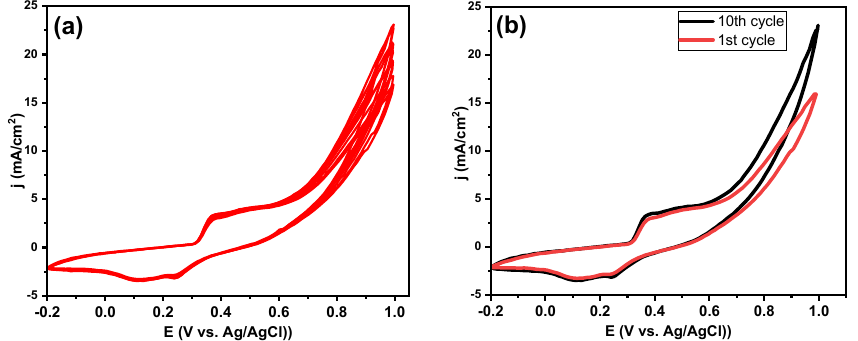
Figure 4. ( a ) CV curve acquired over ten cycles and ( b ) 1st and 10th cycle in 1.0 M KOH at a scan rate of 50 mV/s.